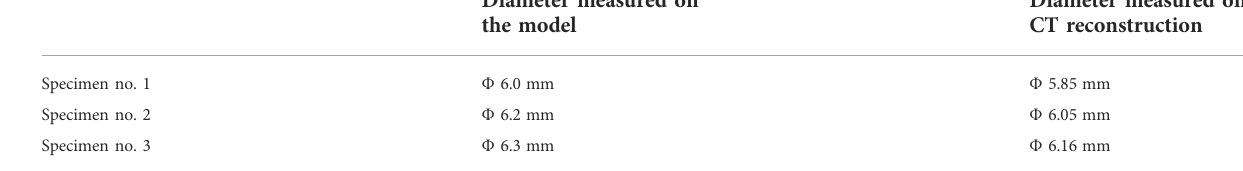
TABLE 1 Differences between 3D model and CT